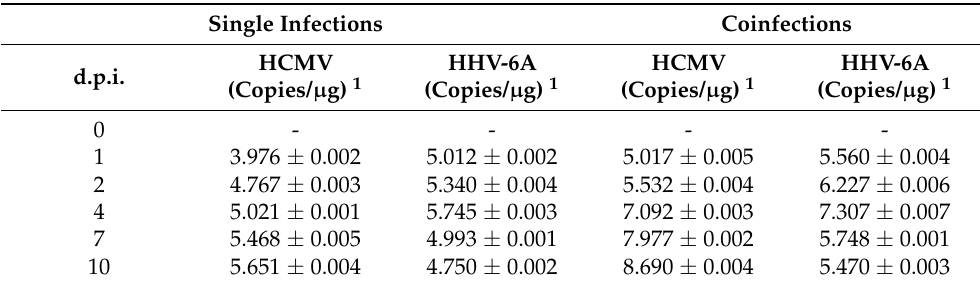
Table 1. HCMV and HHV-6A genome DNA presence in single-infected and coinfected dermal fibroblasts at the indicated days post infection